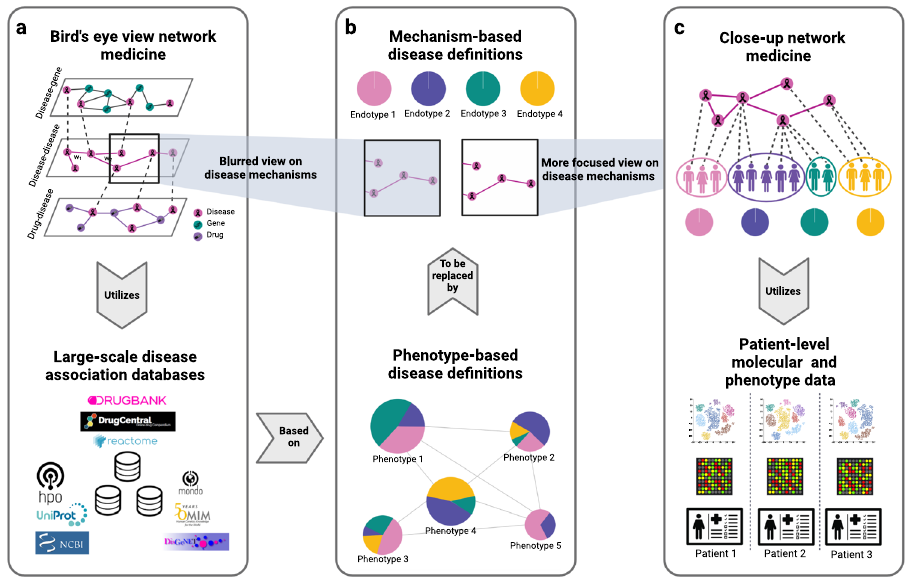
pathomechanisms ( b , top). c Close-up network medicine uses patient-level mole- culardataand ishence lessdependentonthe phenotype-baseddiseasede fi nitions that network medicine aims to replace by mechanism-based